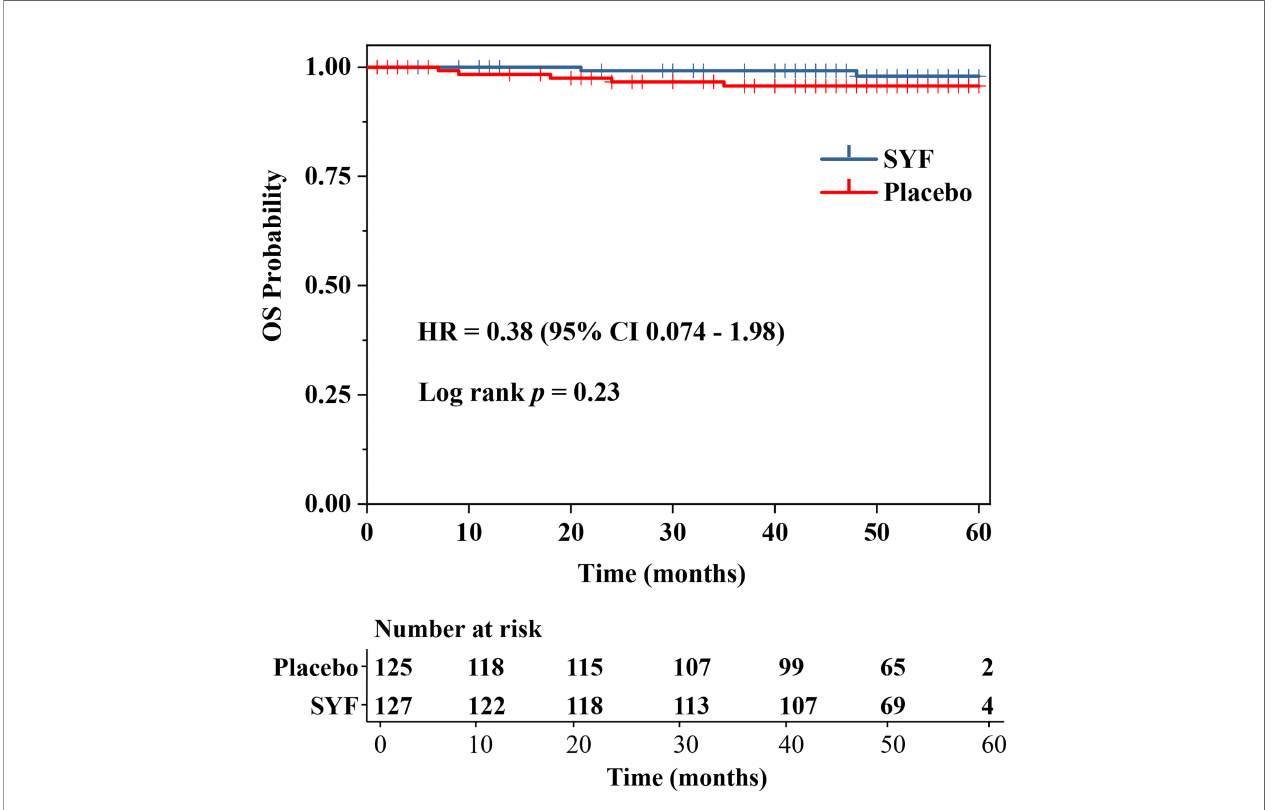
FIGURE 3 | Overall